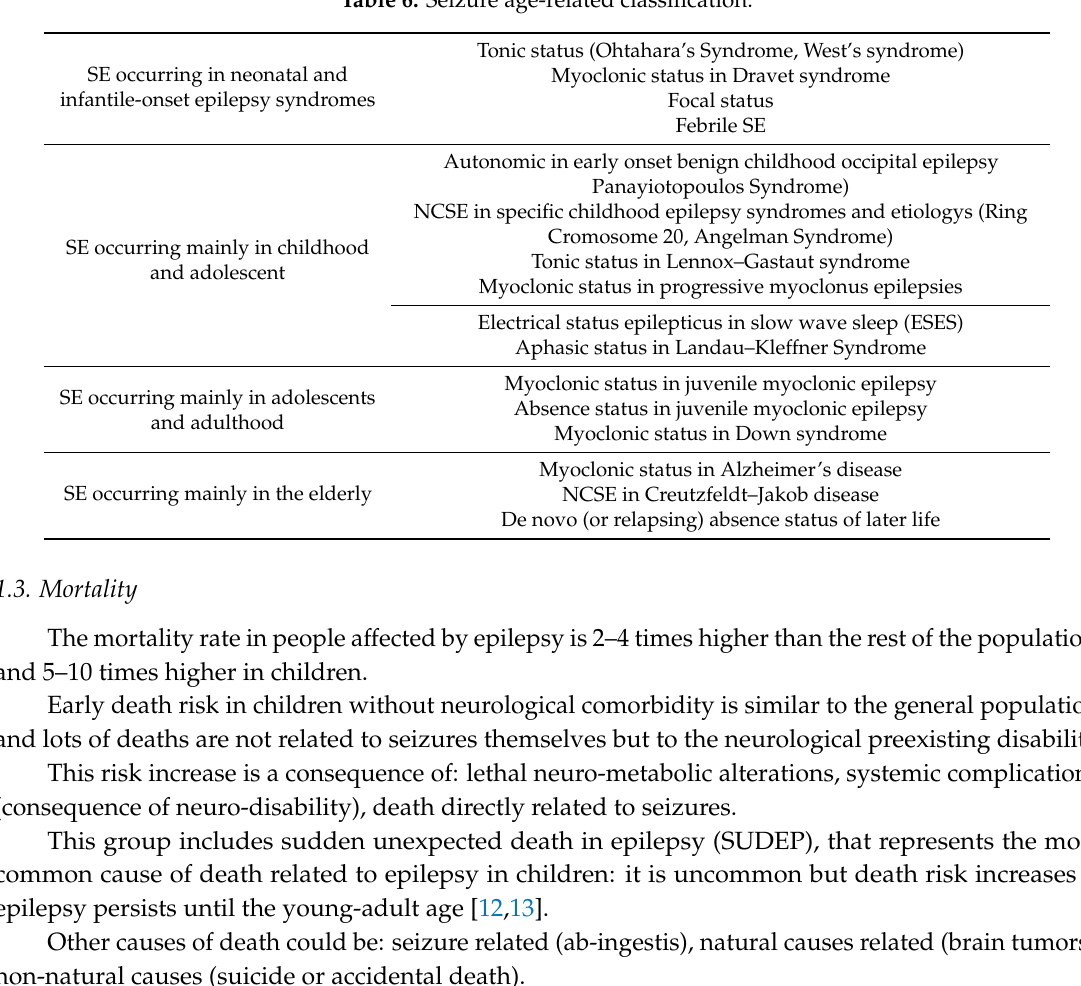
Table 6. Seizure age-related